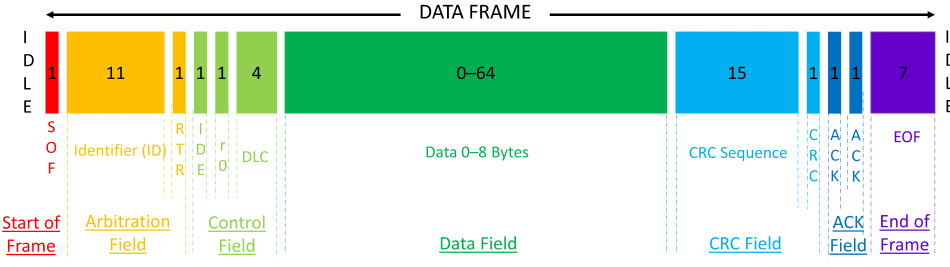
Figure 2. CAN-bus data frame